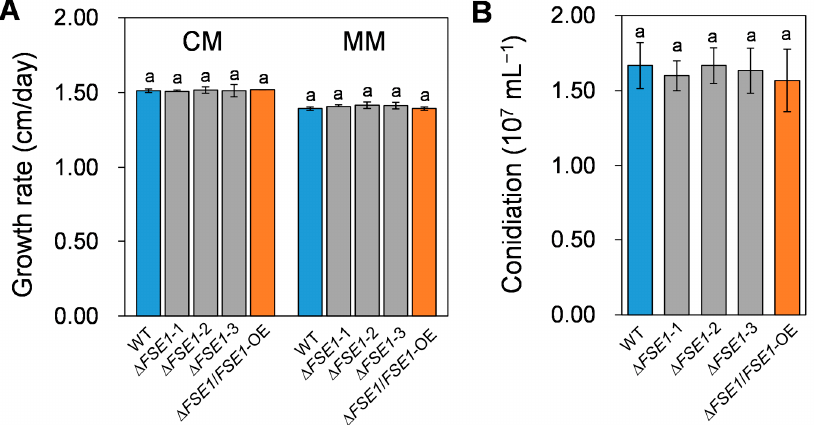
Figure 2. Growth rate and conidiation assays of the FSE1 knockout and overexpression mutants. ( A ) Foc TR4 strains were grown on complete (CM) or minimal agar medium (MM) for 5 d, after which the colony growth rates were calculated. ( B ) Foc TR4 strains were grown in liquid complete medium for 3 d, and the conidiation production was counted with Hemocytometer. Bars represent standard deviations (SD). Data are shown as the means ± SD, and columns with different letters indicate significant difference ( p < 0.05).